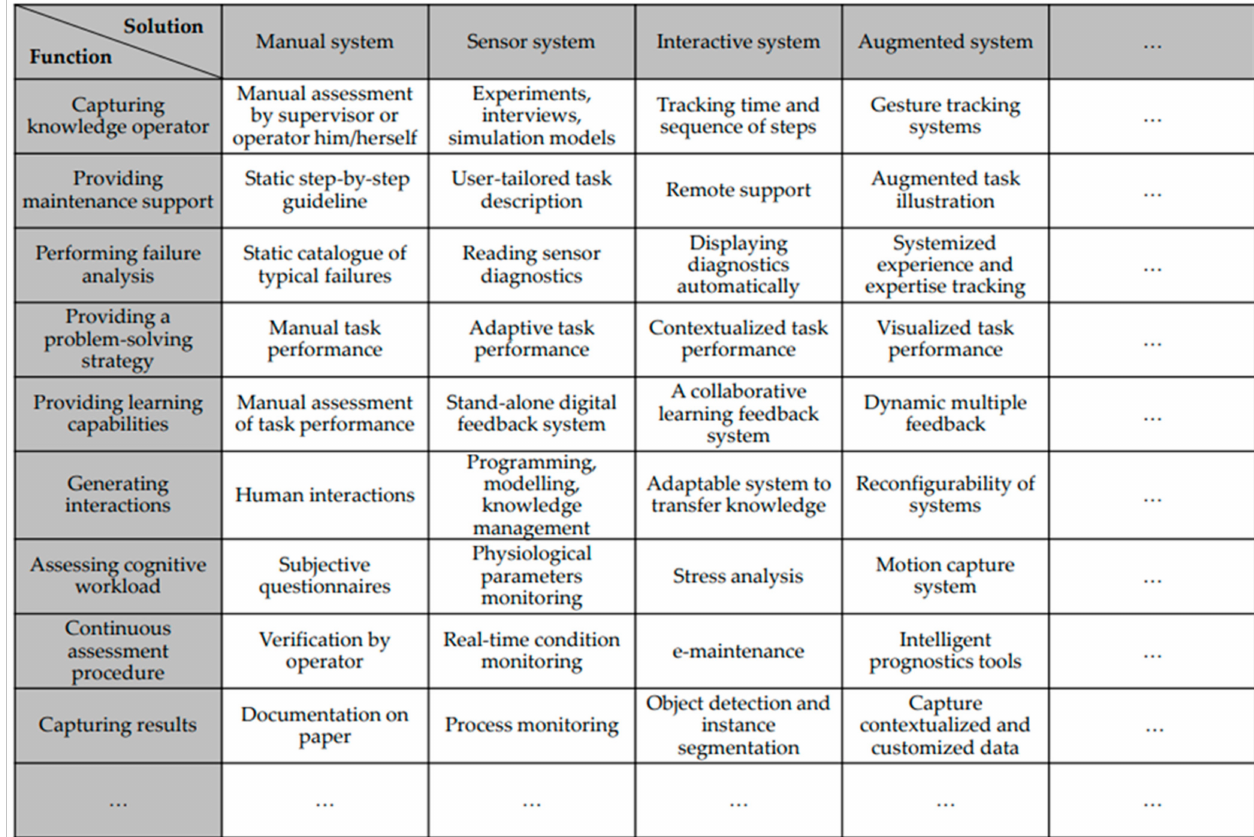
Figure 3. Functional analysis of adaptive capabilities and potential